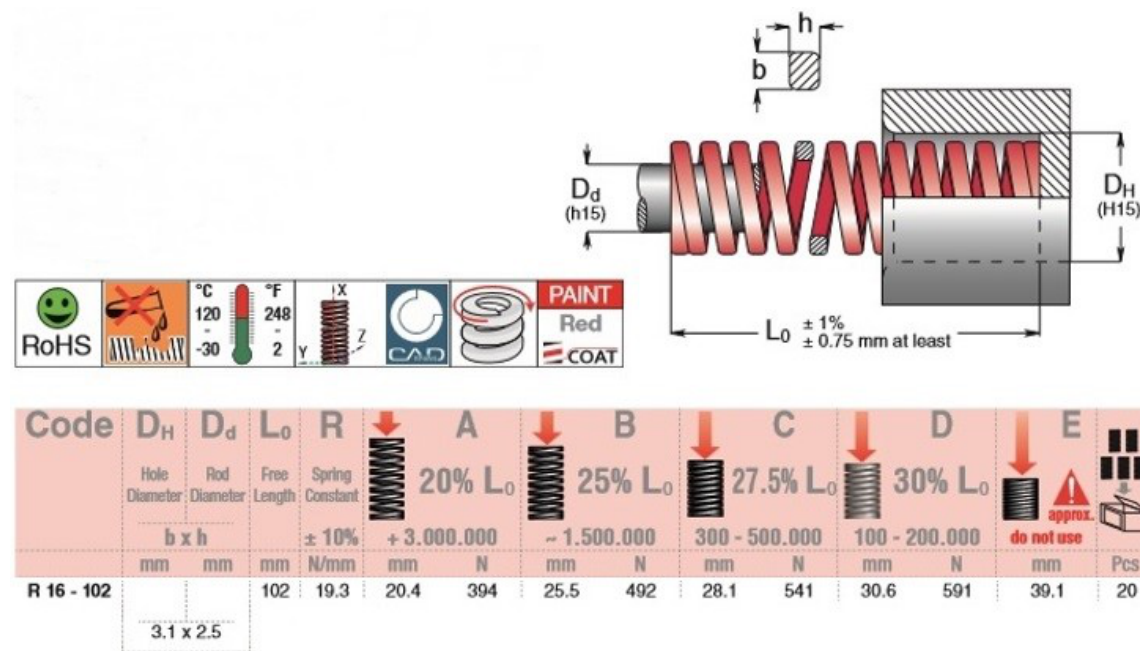
Figure 7: Basic parameters of coil compressive spring R16-102 [7]